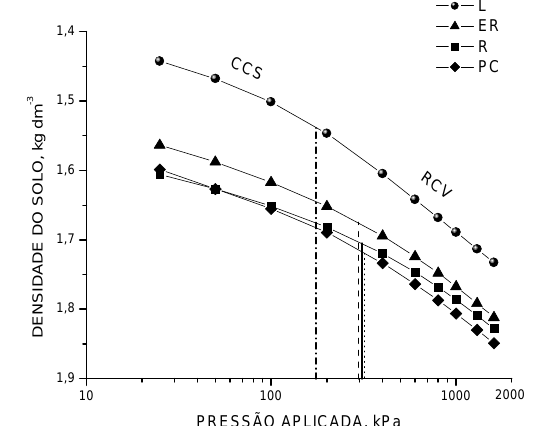
Figura 1. Curvas de compressão uniaxial nas posi- ções: linha (L), entre rodado (ER), rodado (R) e projeção da copa (PC), no potencial ( yyyyy ): -10 kPa. As linhas verticais separam as duas regiões na curva de compressão uniaxial (CCS = curva de compressão secundária e RCV = reta de compressão virgem) nas posições L, ER, R e PC,